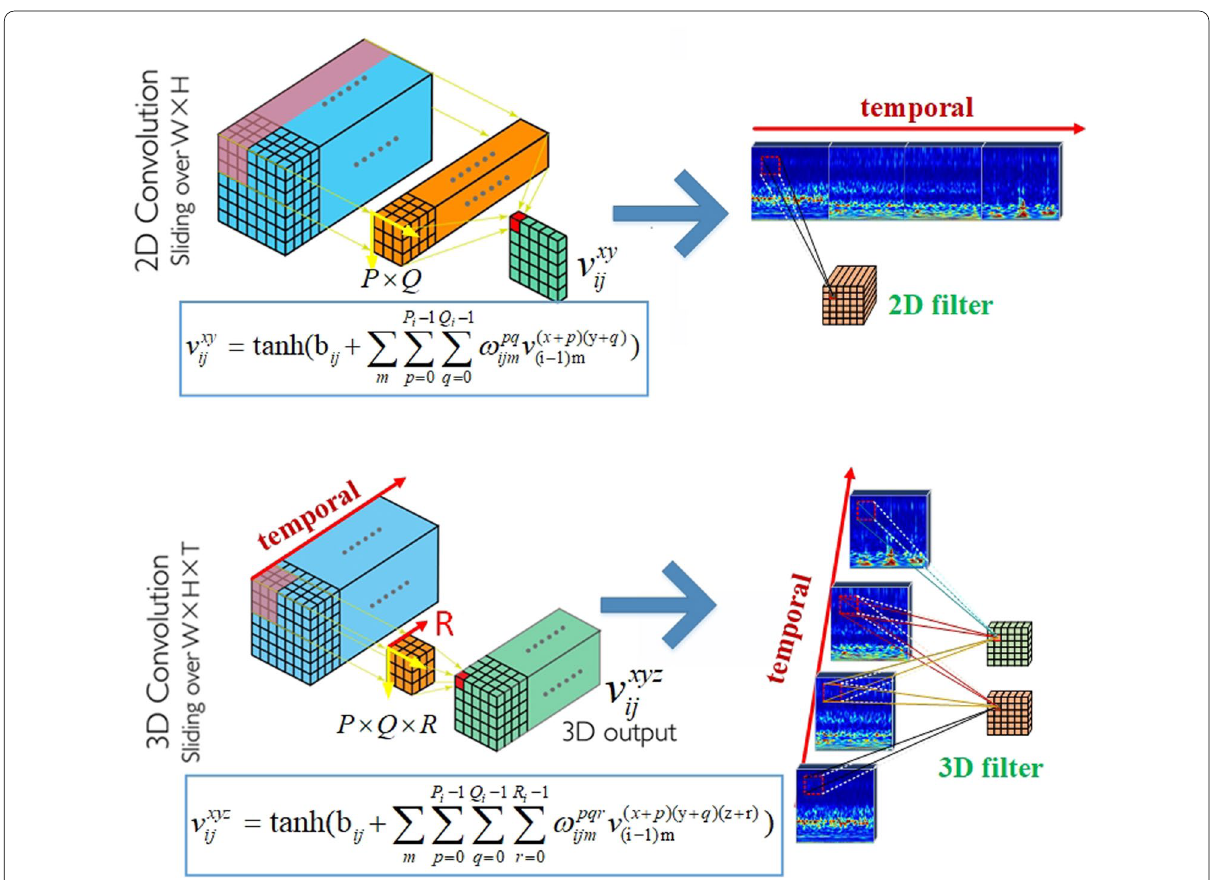
Figure 2 Comparison between 2D and 3D